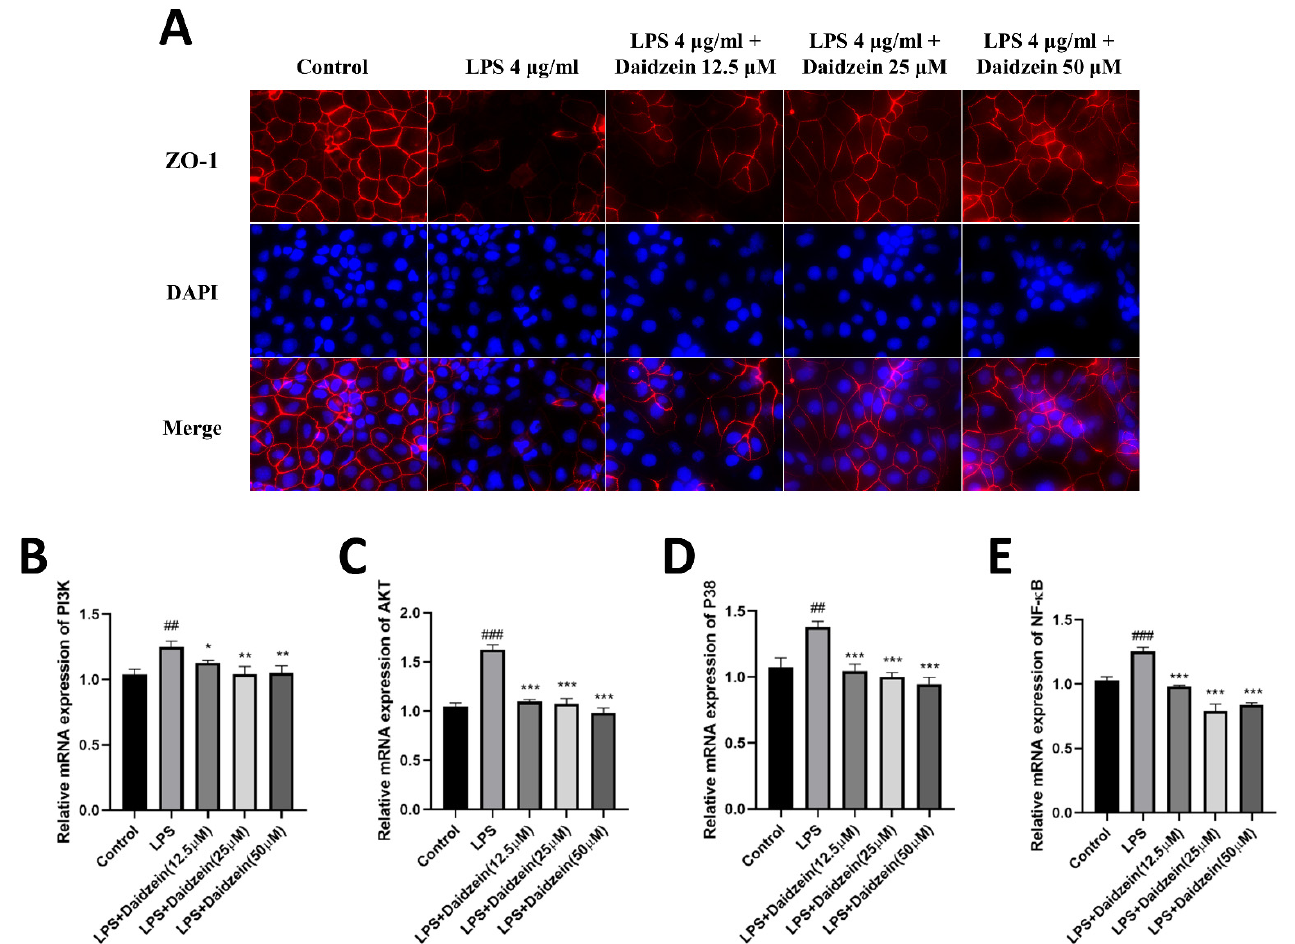
Figure 4. Daidzein ameliorated the tight junction of the ZO ‐ 1 protein and suppressed the gene ex ‐ pression of the PI3K/AKT and P38 pathways. ( A ) The intercellular junction of the ZO ‐ 1 protein. The red signal indicates ZO ‐ 1, and the blue one indicates nuclei. ( B , C ) The mRNA expression levels of the PI3K/AKT pathways. ( D ) The mRNA expression levels of the P38 pathways. ( E ) The mRNA expression levels of p ‐ NF ‐κ B and NF ‐κ B (mean ± SD, n = 3), * p < 0.05, ** p < 0.01, and *** p < 0.001 versus LPS ‐ treated alone. ## p < 0.01, and ### p < 0.001 versus control.